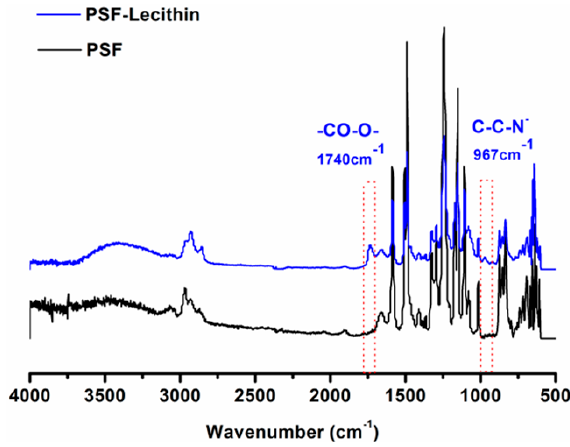
Figure 5. ATR-FTIR spectra of the blank and lecithin-modified RGM-PSF.